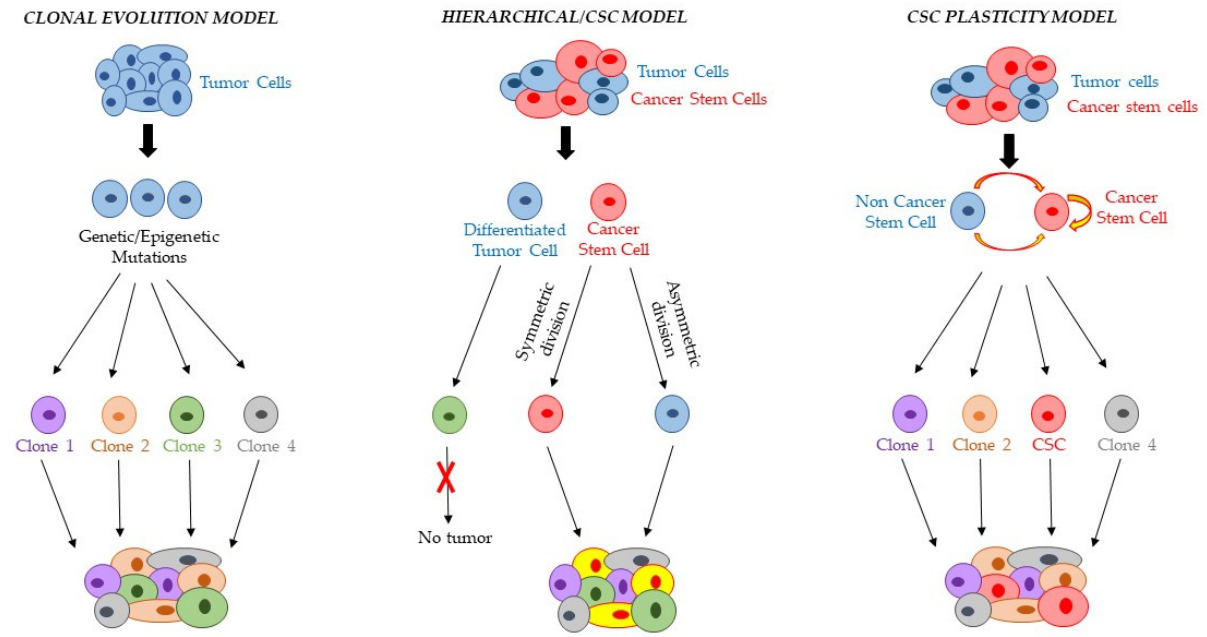
Figure 1. Schematic overview of different models that can explain intratumor heterogeneity. Ac- cording to the clonal evolution model, all cells in the tumor have equal tumorigenic potential. The tumor cells may undergo genetic and/or epigenetic alterations, generating different tumor clones with the same ability to initiate tumor growth. On the contrary, the hierarchical or CSC model suggests that only cancer stem cells (CSCs) can initiate and sustain tumor growth. CSCs can generate heterogeneous tumor cell progeny via asymmetric division and maintain the CSC component via symmetric division. The CSC plasticity model assumes that tumor hierarchy is very dynamic. Plastic cancer cells can constantly shift between non-CSC and CSC states depending on various intrinsic and extrinsic stimuli, giving rise to a heterogeneous tumor population.